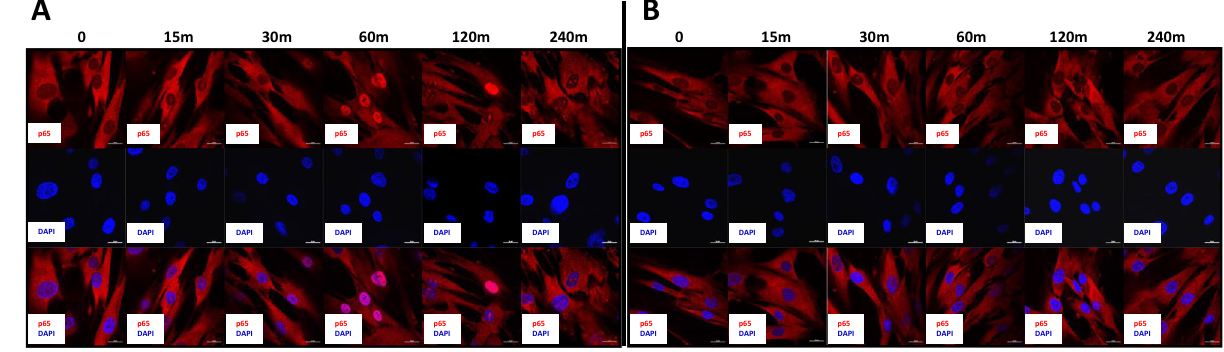
Figure 2. Confocal microscopy imaging to demonstrate the nuclear translocation of p65 by DPP stimulation. ( A ) DPSCs were stimulated with DPP (500 ng/ml) for indicated times and cellular localization of p65 (Red) was assessed by confocal microscopy. DAPI (blue) depicts the nucleus. Scale bar: 20 µm ( B ) Cellular localization of p65 was determined after treating DPSCs with the NF-κB inhibitor TPCA-1 (10 µM) for 1 h and then stimulated with DPP at the indicated times. Note absence of nuclear localization of p65 with TPCA-1